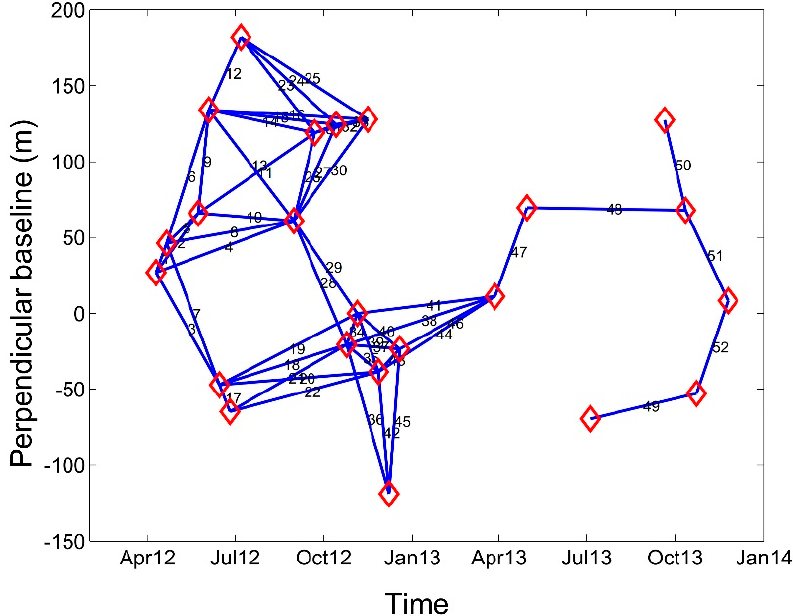
Figure 3. Baseline information of interferometric pairs. Lines represents 52 SB interferograms formed. Red diamonds represent SAR acquisitions.